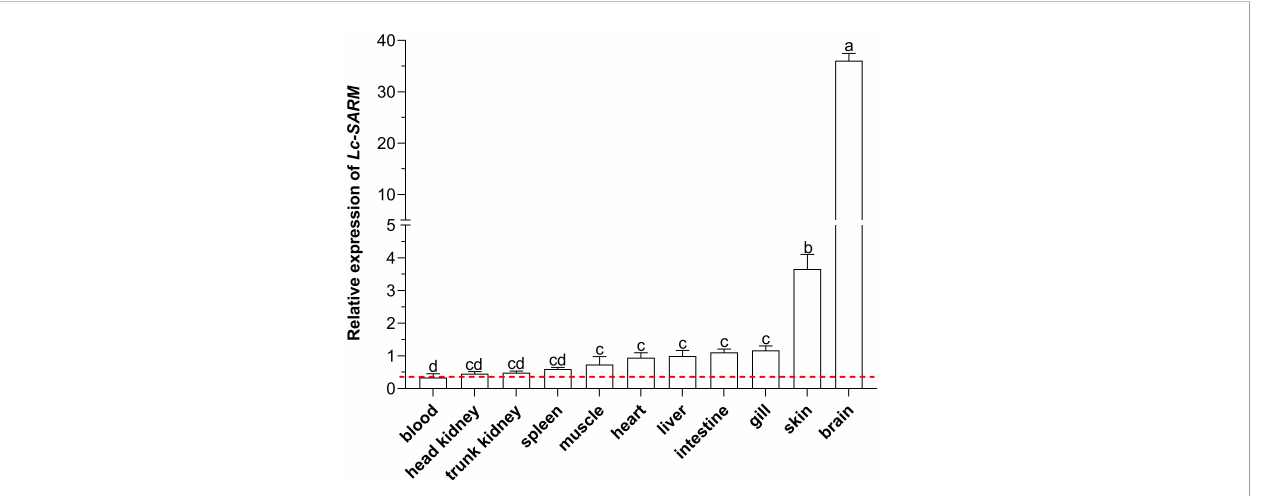
FIGURE 4 Organs/tissues distribution analysis of Lc-SARM in large yellow croaker. The mRNA expression levels of Lc-SARM in 11 various organs/tissues of the healthy fi sh (n = 6) were detected by qRT-PCR analysis, with normalizing to the expression of L. crocea b -actin . The lowest expression level of Lc-SARM detected in the blood was marked with a red dotted base line. All of the data are shown as the mean of three individual experiments, with bars representing the SE. Different letters above the bars indicate statistically signi fi cant differences between the groups ( P < 0.05).